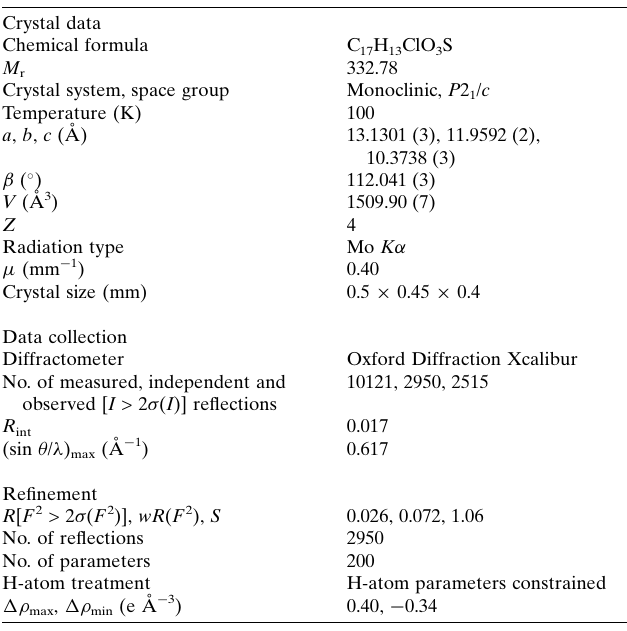
Table 2 Experimental details.